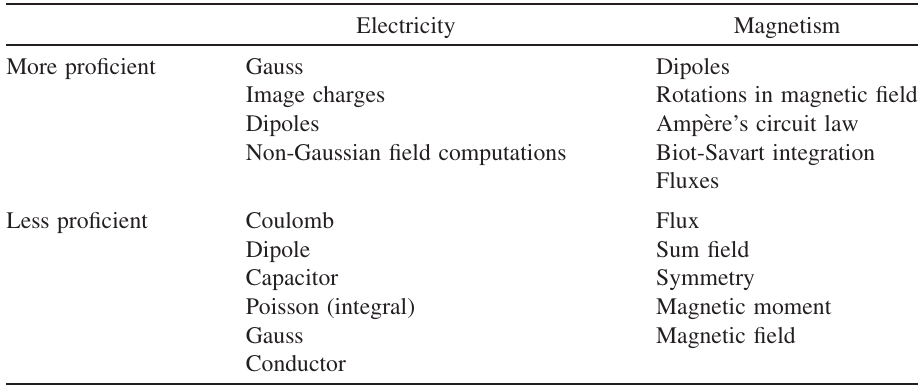
TABLE VI. Stack labels by a more and a less proficient student.